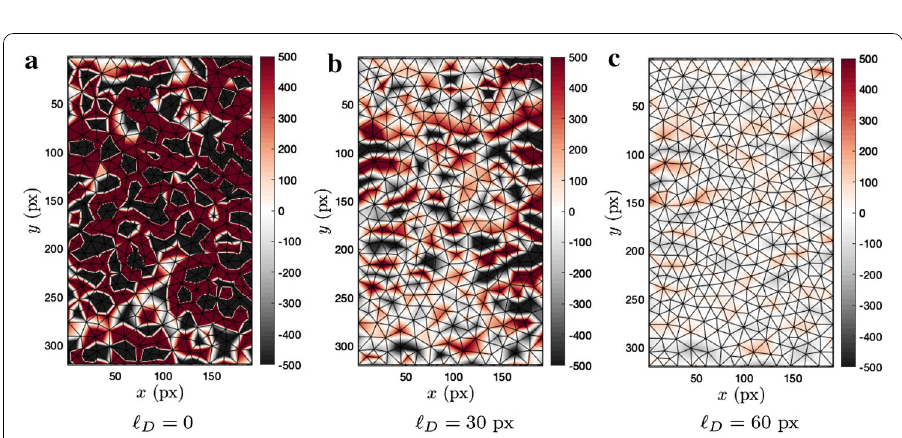
Fig. 5 Temporal change of displacement ( a ) and acceleration ( b ) with three different dynamic regularizations on 180 frames of a 1 Mfps film. The physical size of one pixel is 500 µ m. The more the DIC analyses are regularized, the closer the measurement to the reference solution